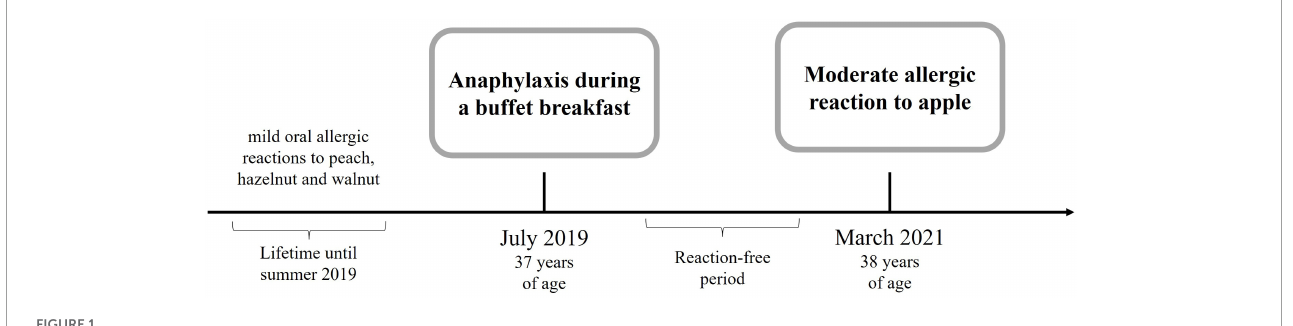
FIGURE1 Timeline of the patient’s allergological